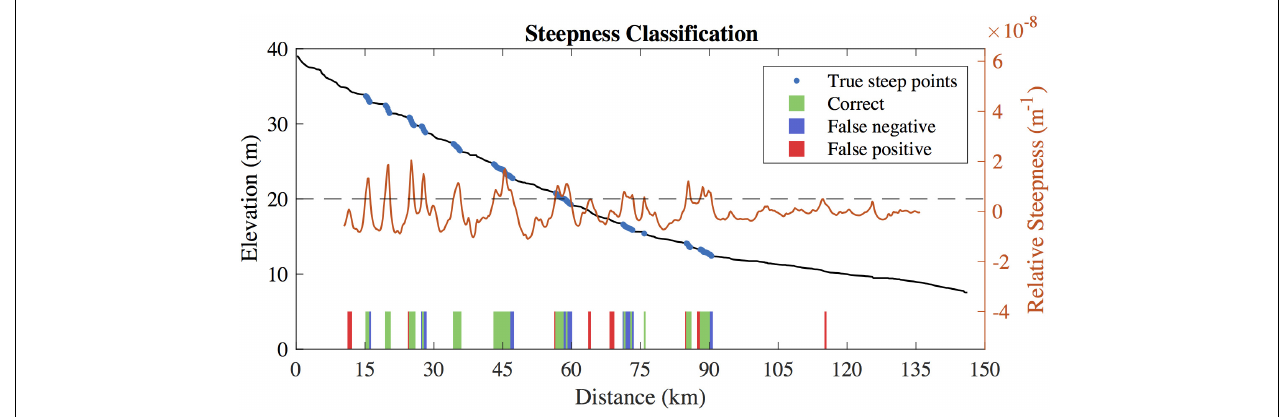
FIGURE 7 | Average truth profile for the Sacramento River with calculated relative steepness values and threshold (black dashed line). The colored bars on the bottom compare the classification of the average truth and SWOT profiles.